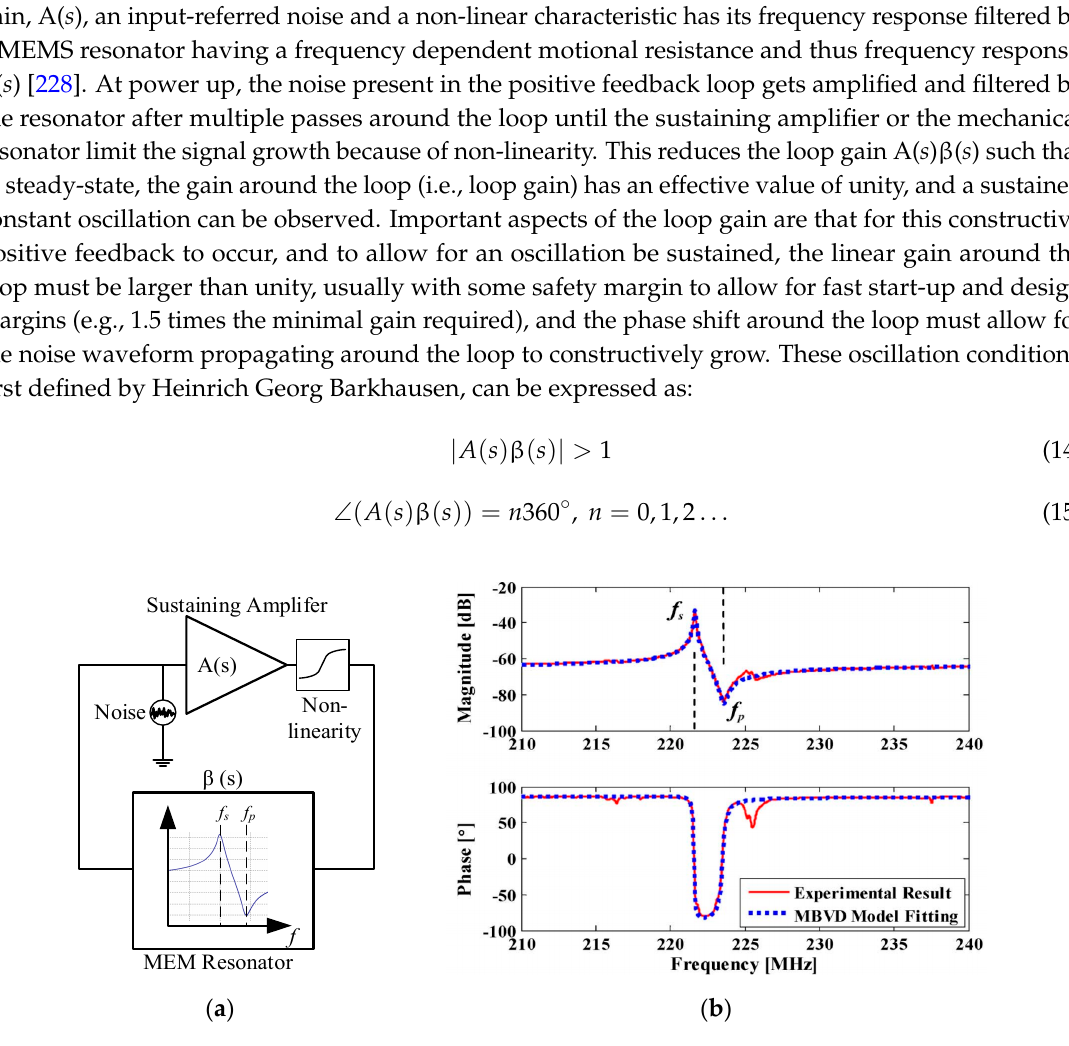
Figure 22. ( a ) Typical MEMS resonator-based oscillator loop; and ( b ) typical resonator transmission characteristic amplitude and phase [162]. © 2010 IEEE. Reprinted with permission from Multifrequency Pierce Oscillators Based on Piezoelectric AlN Contour-Mode MEMS Technology by Zuo in J. Microelectromech. Syst. , 2010.